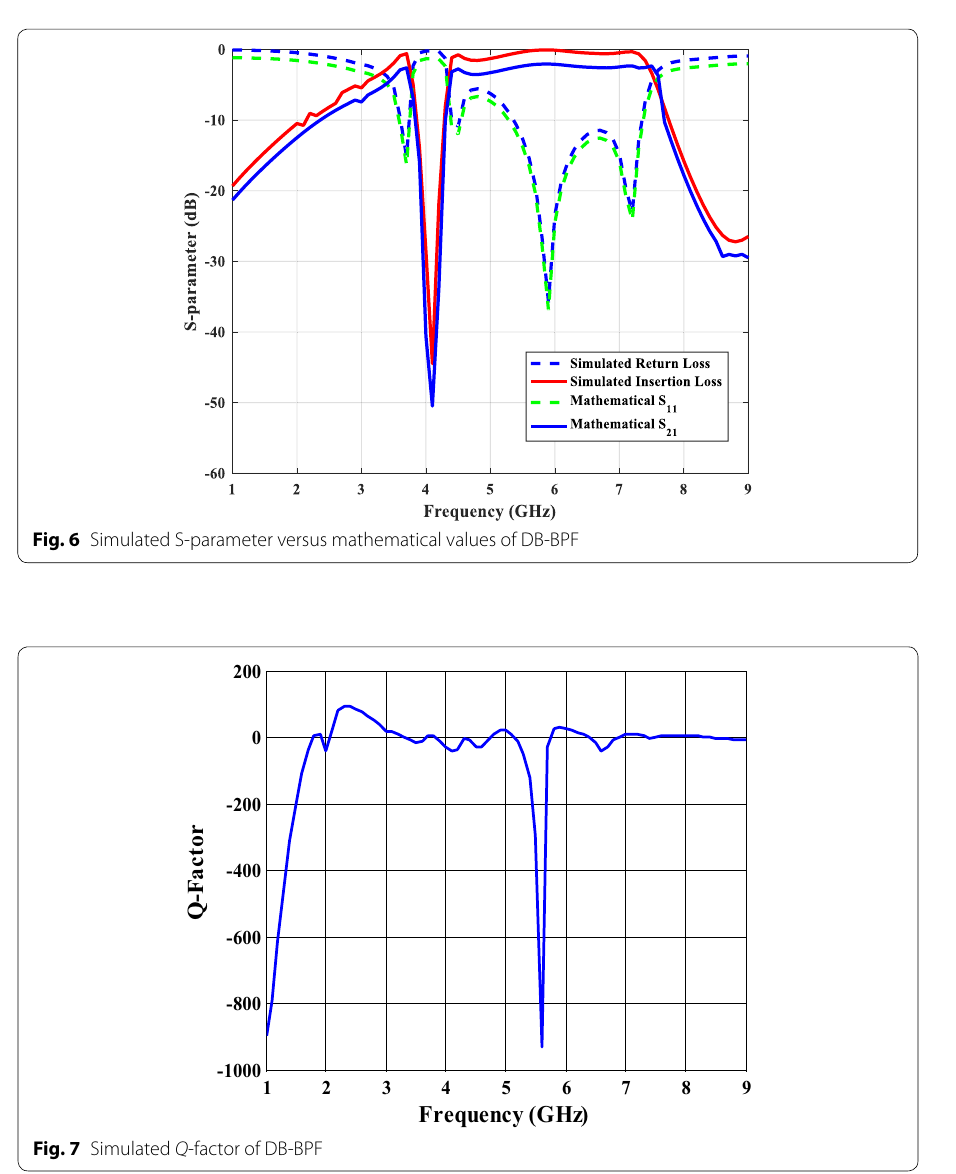
Fig. 7 Simulated Q -factor of